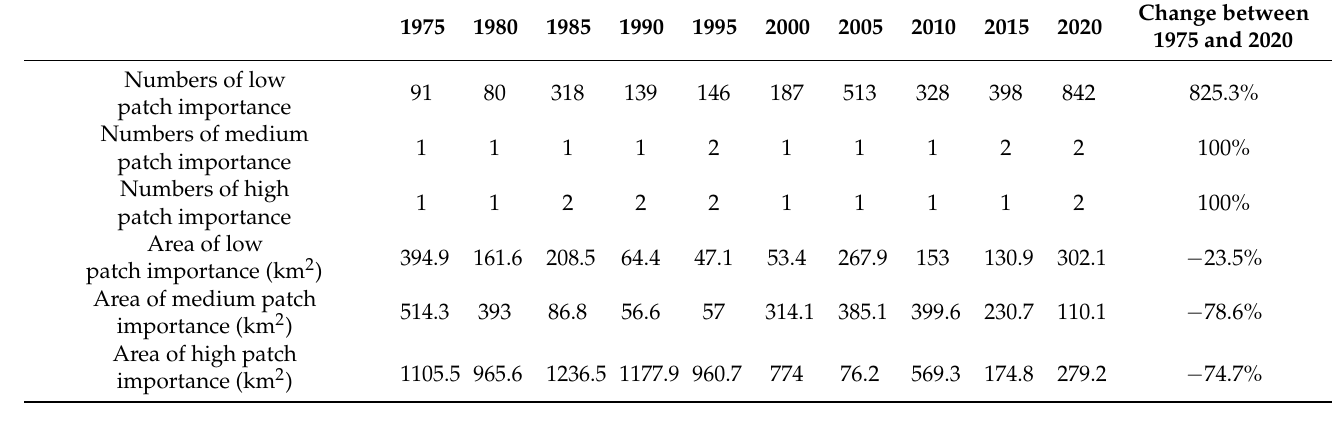
Table 3. Number and area of patches with low, medium, and high patch importance in the Yellow River Delta between 1975 and 2020.